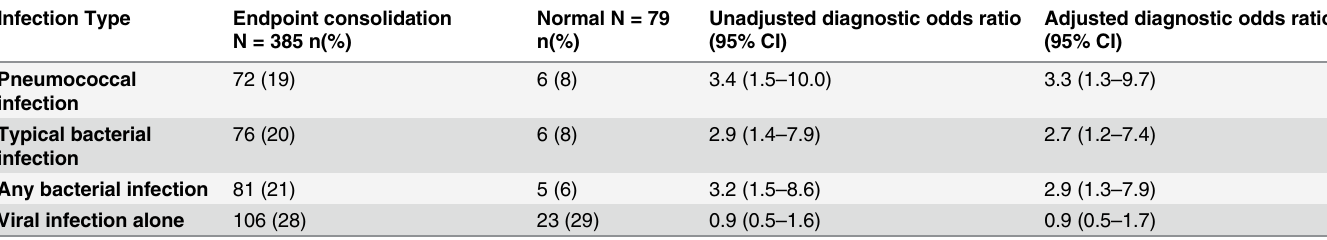
Table 3. Association between endpoint consolidation and different types of infections. Infection Type